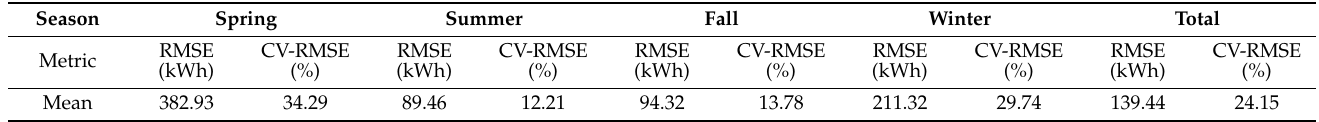
Table 5. Summary of the indicator for RMSE and CVRMSE.